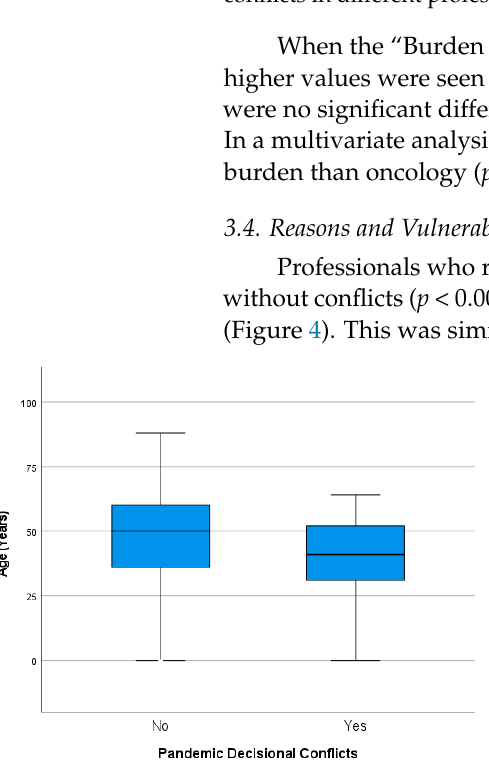
conflicts in different professional groups.